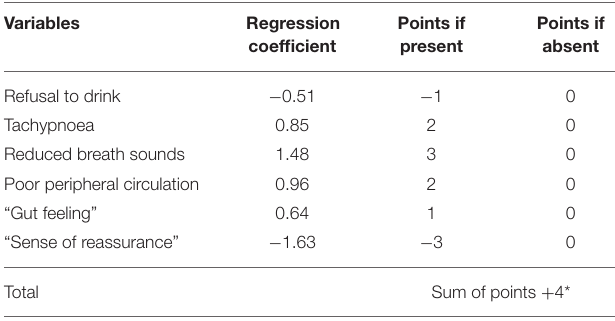
TABLE 8 | Clinical score to assess the risk for serious bacterial infection.